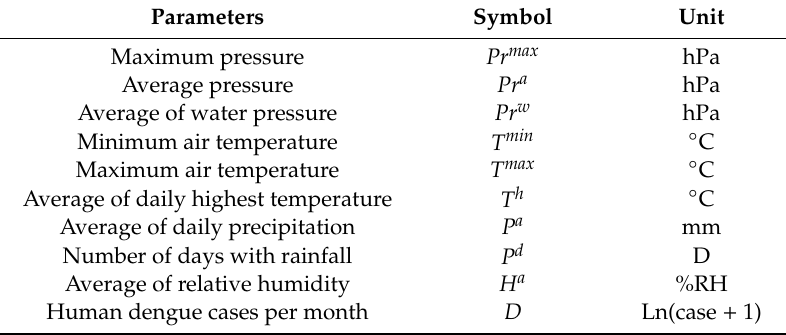
Table 1. The feature parameters used in the long short-term memory (LSTM) modeling in this study. Parameters